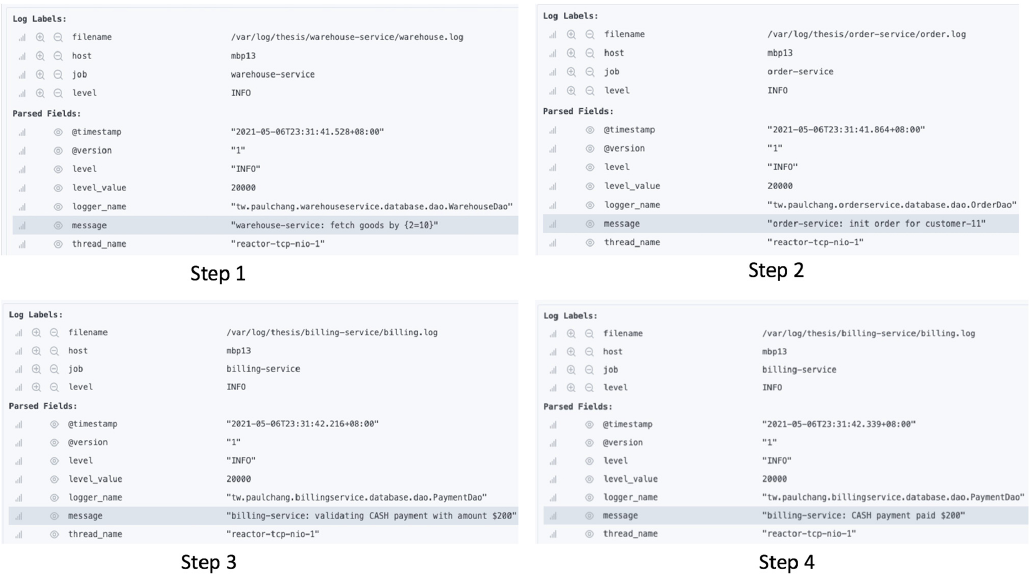
Appl. Sci. 2022 , 12 , x FOR PEER REVIEW Figure 7. Steps 1–4 in version 1 (deploying standard saga pattern). Figure 7. Steps 1–4 in version 1 (deploying standard saga pattern).